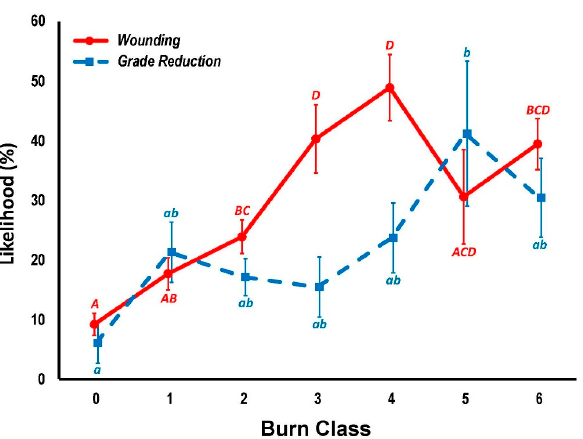
Figure 2. The likelihood of wounding (red) and conditional likelihood of grade reduction assuming wounding (blue) with increasing burn class (i.e., numbers of prescribed fires). Error bars are ± 1 standard error. Letters indicate significant differences ( p < 0.05, Tukey’s HSD) among mean likelihoods of the burn classes for both wounding (capitalized, red) and grade reduction (lower case, blue).